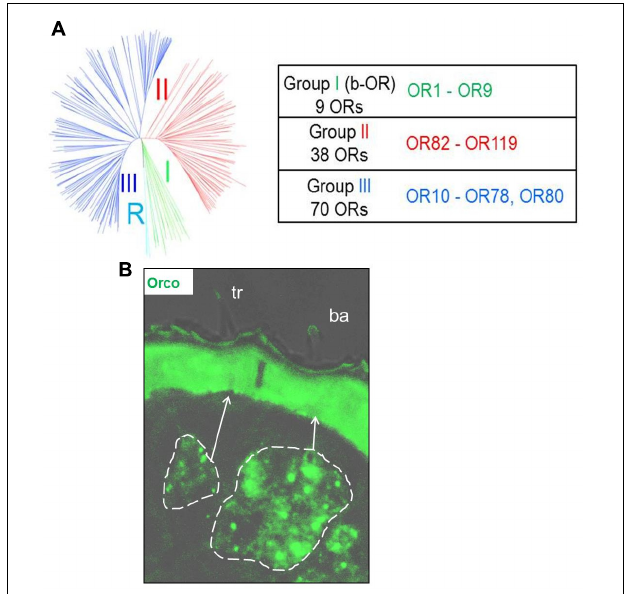
FIGURE 1 | (A) The schematic phylogenetic tree of locust OR sequences is adapted from Pregitzer et al., 2017. Schistocerca ORs are grouped within 3 distinct monophyletic lineages. Group I was previously named b-ORs, due to its close proximity to the basal Orco root group, marked by a R. A monophyletic group diverging from an inner-node in the phylogenetic tree, supported by a bootstrap value of 85, was classified as group II. The remaining branches, which diverge from another node with a bootstrap value of 59, were assigned as the group III. OR types from each of the three groups are listed in the table. (B) Visualization of olfactory sensory neurons in sensilla basiconica (ba) and sensilla trichodea (tr) in tissue sections from locust antennae using Orco as a marker. The cluster of OSNs is delineated by white dish lines indicating a small group of Orco positive cells in sensilla trichodea and a large cluster of Orco positive cells in sensilla